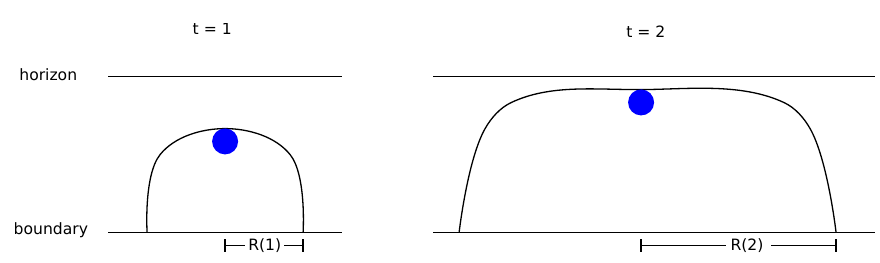
Figure 7 . We show two di(cid:11)erent time slices of the geometry outside the horizon of the black hole. The position of the falling particle (blue dot) is shown at each time, along with the (growing) minimal entanglement wedge that contains